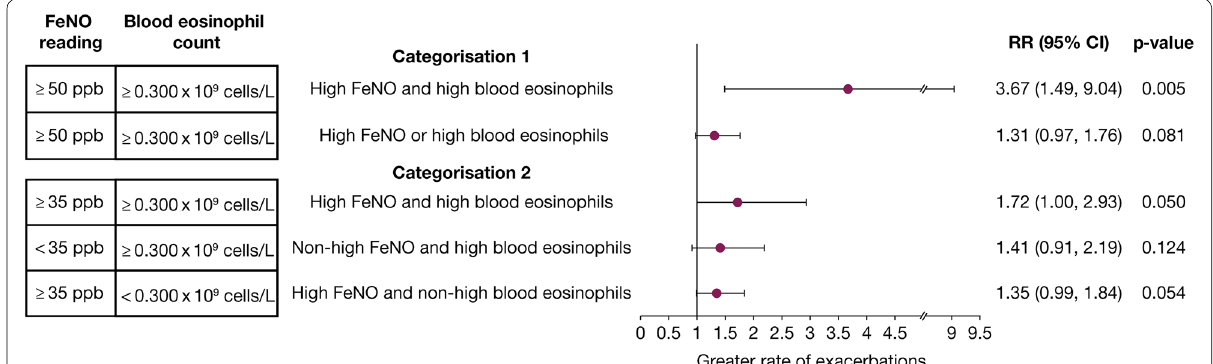
Fig. 3 Comparison of exacerbation rates of cohorts relative to non‑high FeNO and non‑high blood eosinophil cohorts. CI confidence interval, FeNO fractional exhaled nitric oxide, RR rate